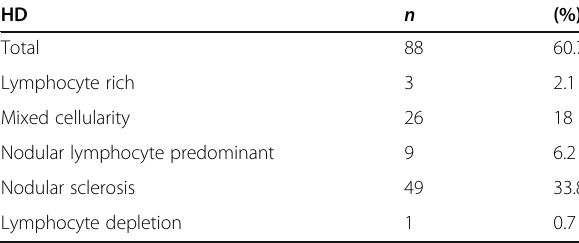
Table 2 Types of HD lymphoma in this